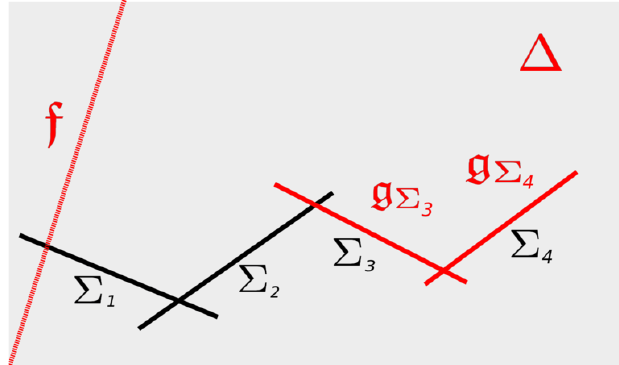
Figure 1. Schematic description of the geometric engineering of the tensor branch of a 6d SCFT in F-theory. The rational curves (cid:6) I are in one-to-one correspondence with tensor multiplets, whose scalars’ vacuum expectation values coincide with vol((cid:6) I ). In red we have depicted the discriminant locus, corresponding to the divisor (cid:1) of the F-theory base. In this example, we have a (cid:13)avor divisor intersecting the curve (cid:6) 1 , carrying (cid:13)avor symmetry f , while the compact curves (cid:6) 3 and (cid:6) 4 both support non-abelian gauge